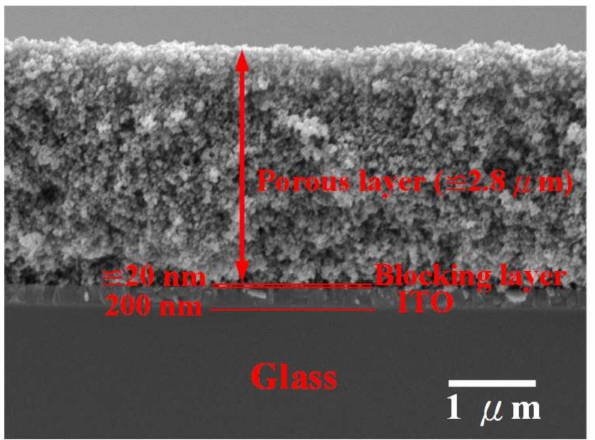
Figure 5. SEM cross-sectional image of the TiO 2 mesoporous coated on TiO 2 blocking layer/ITO/glass by the sol–gel